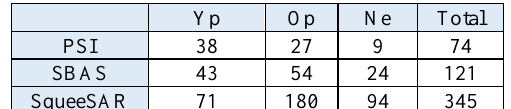
Table 1: Number of scatterers detected by PSI, SBAS and SqueeSAR techniques in the landslide body. Yp, Op and Ne refer to younger part, older part and northern edge of the landslide, respectively.